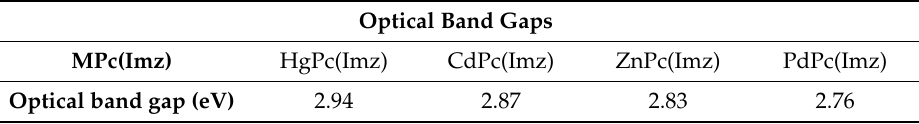
Table 1. Values of optical band gaps of MPc(Imz) (M: Zn; Hg; Cd; Zn;